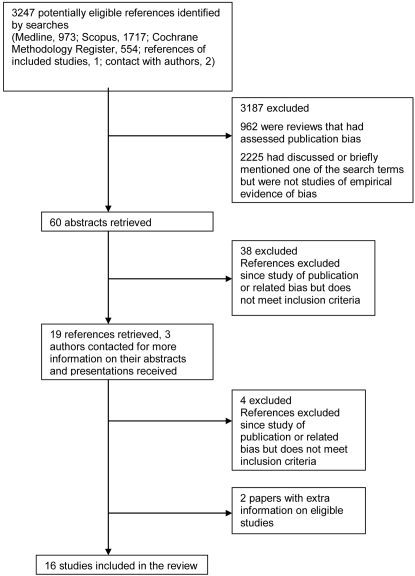
QUOROM flow diagram.